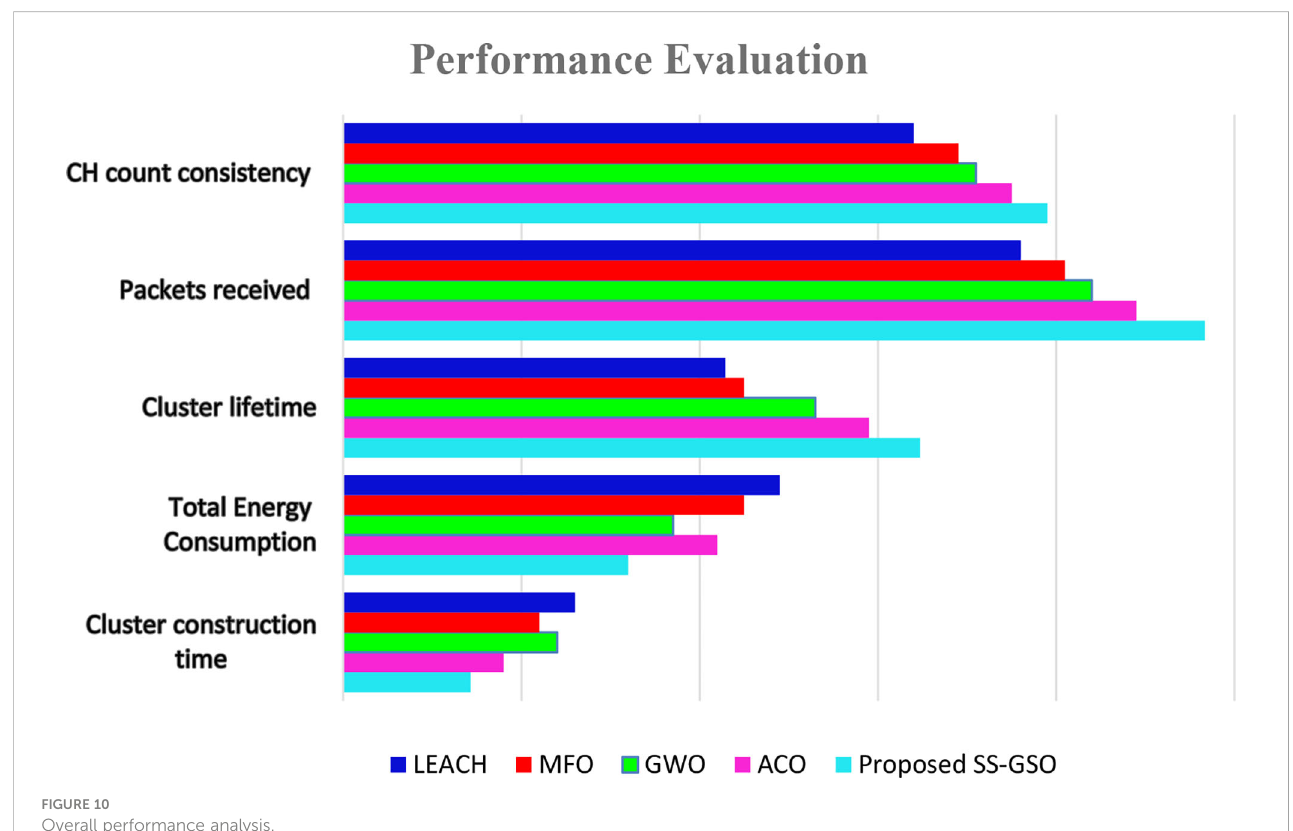
FIGURE 10 Overall performance